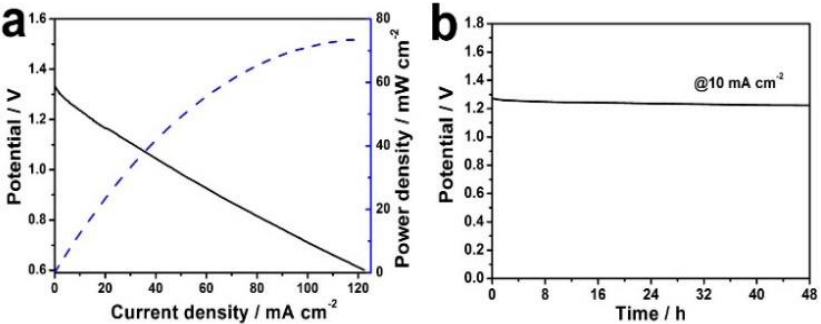
Figure 5. ( a ) Polarization and corresponding power density curves of Co 3 O 4 /C−750. ( b ) Galvanos- tatic discharge curve of Co 3 O 4 /C−750 at current density of 10 mA·cm −2